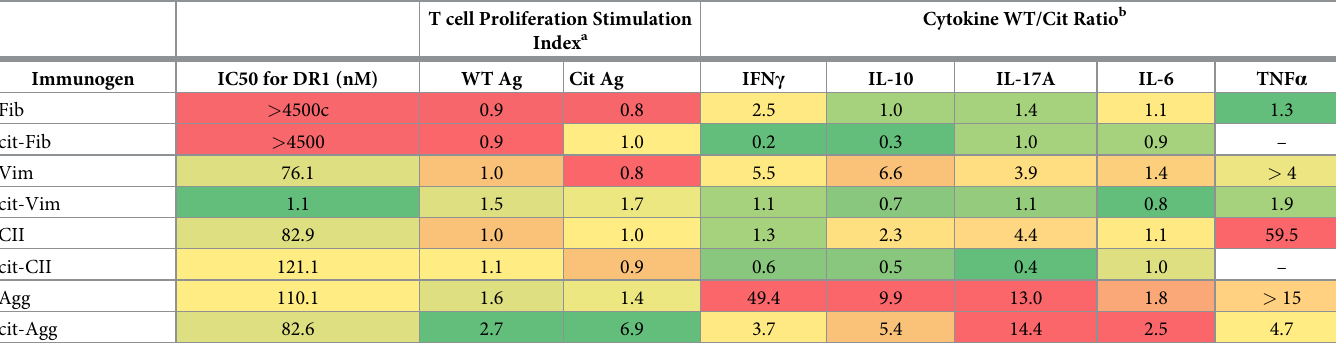
Table 2. Summary of DR binding, T cell proliferation, and cytokine production as stimulated by WT or Cit antigenic peptide.